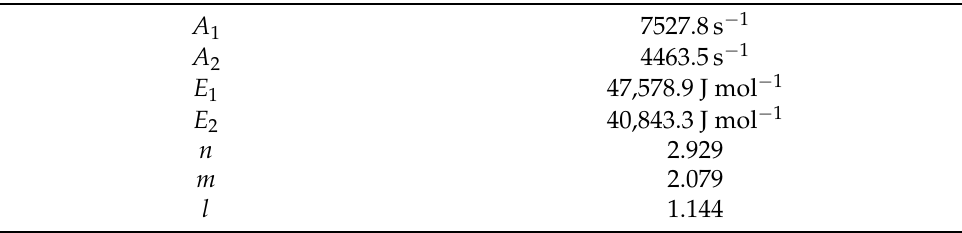
Table 2. Values of fitting parameters found for Equation (4) to describe the curing behaviour of RIMR 426 resin with RIMH 435 curing agent.